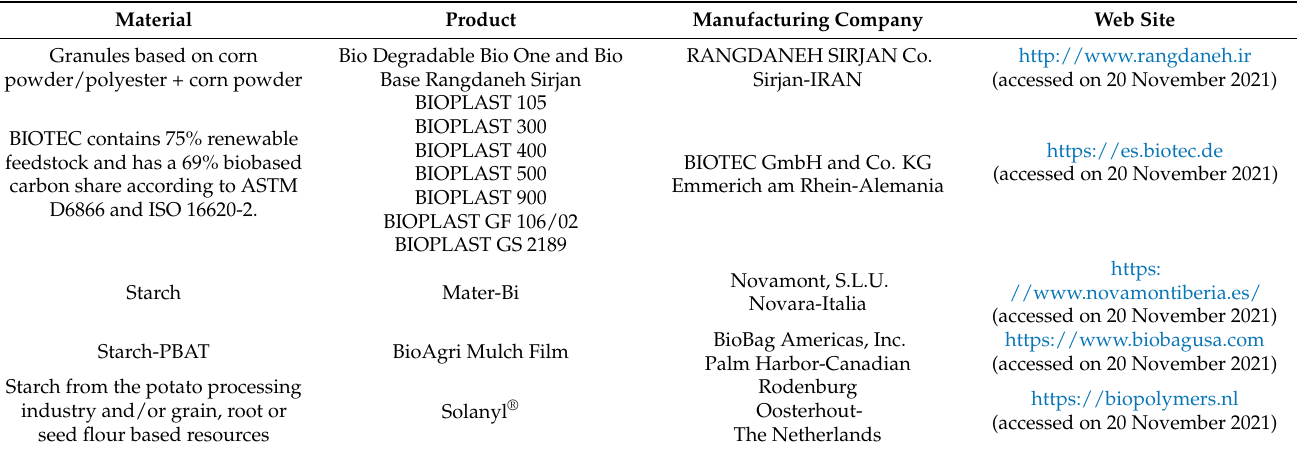
Table 9. Commercially available starch-based materials for food packaging